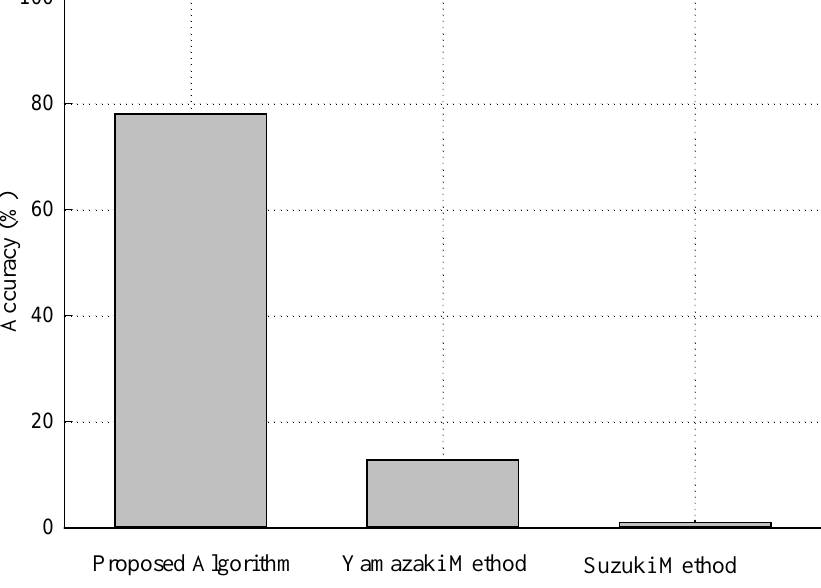
Figure 10. Performance of the proposed algorithm compared to other methods.